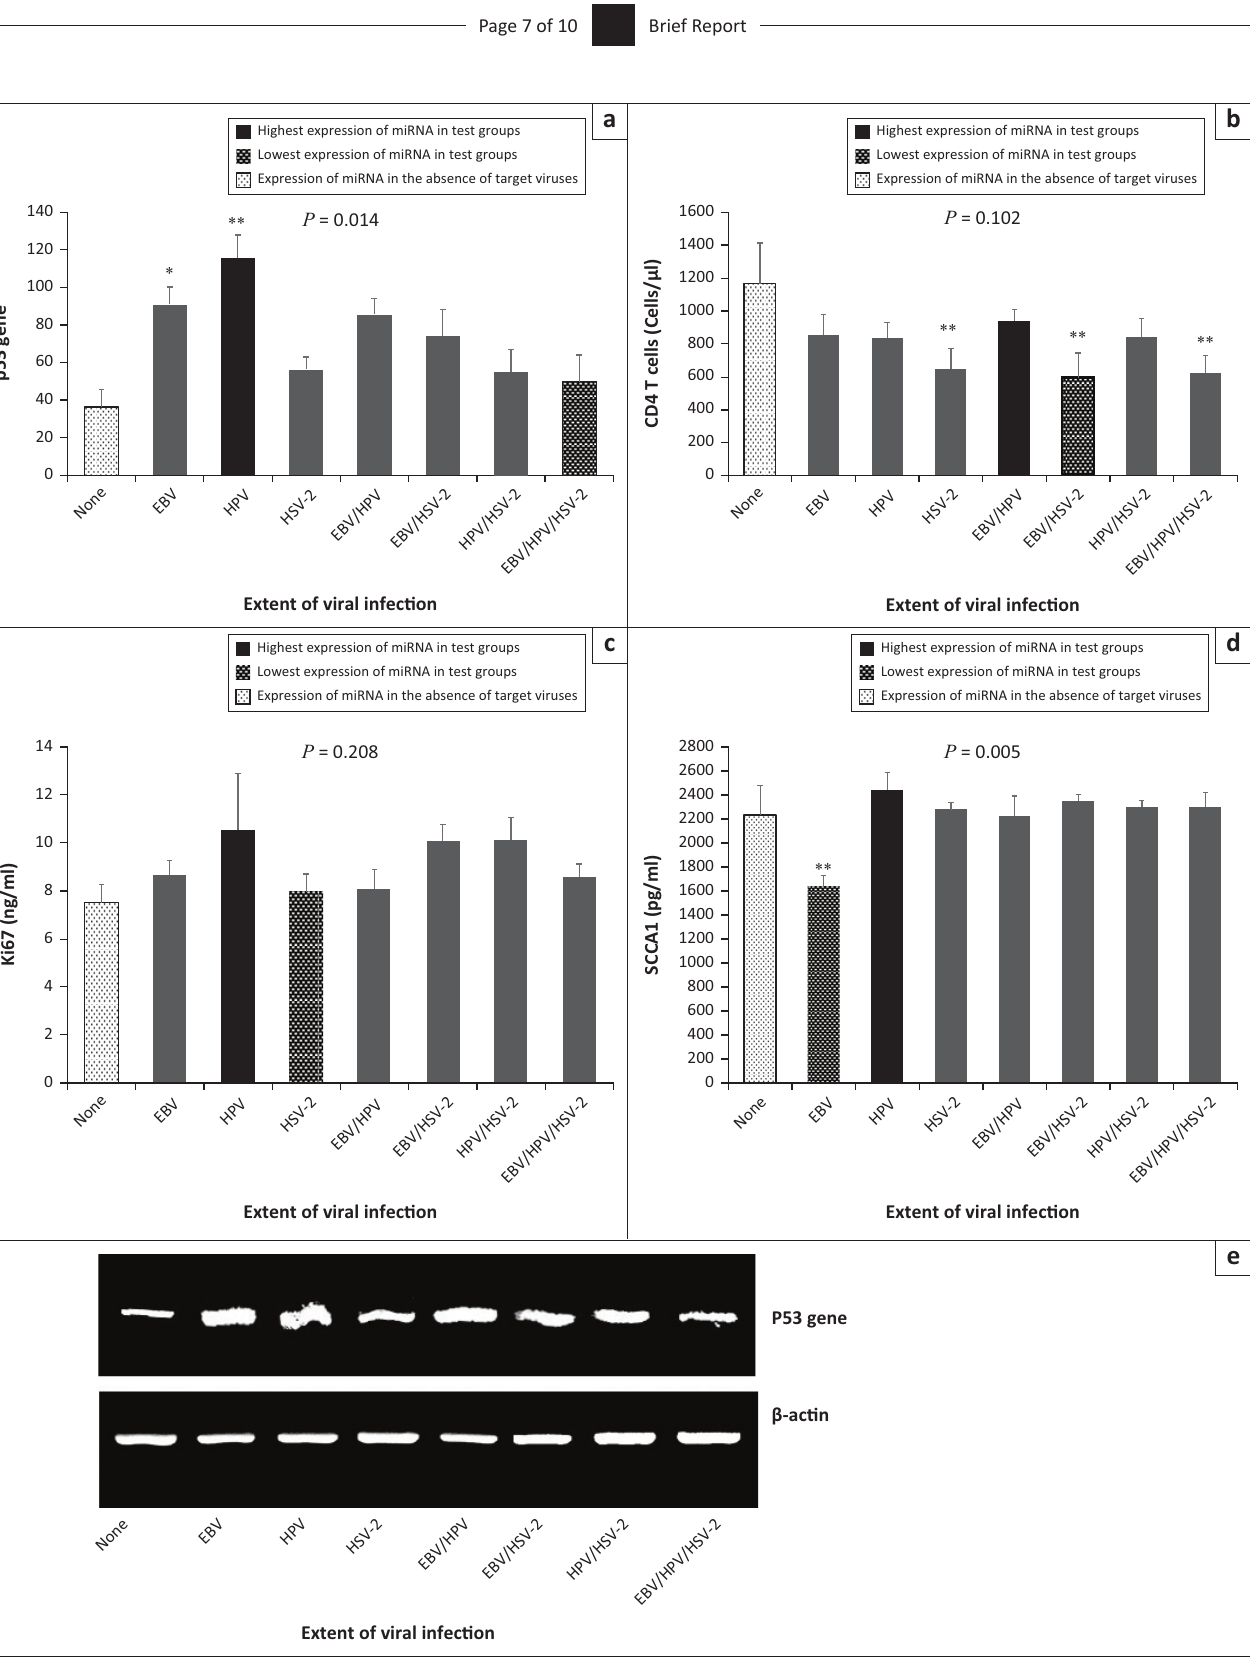
FIGURE 3: Biomarker levels and CD4+ T-cell counts among individuals with and without viral infection, Ogun State, Nigeria, 2018. (a) p53 gene expression was higher among participants with HPV mono-infection and lowest in control group, participants who had no viral infections (None); (b) CD4+ T-cell counts were higher among the control group (None) and lower among those with EBV and HSV-2 co-infection; (c) Ki67 expression was higher among participants with HPV infection and lower in the control (None); (d) SCCA1 expression was higher among participants with HPV mono-infection and lower in those with EBV mono-infection; (e) snapshots of gel amplicons of p53 gene and normalising gene (β-actin) based on viral status (plotted as